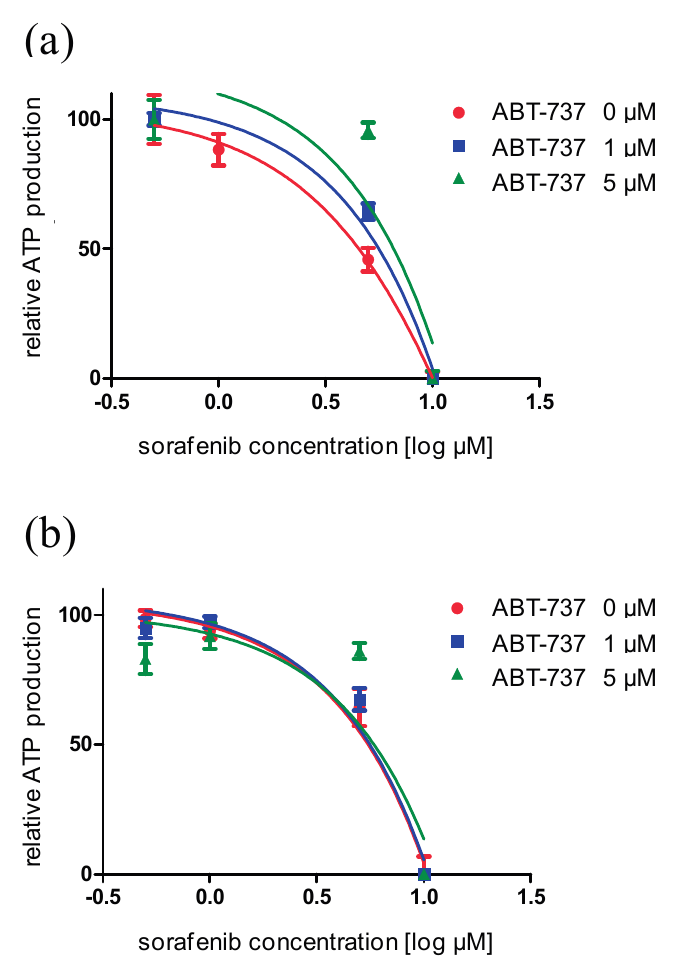
Figure 6. Dose-dependency of sorafenib effects on cell viability in combination with the Bcl-2 inhibitor ABT-737 as measured by total ATP levels, shown exemplarily in T24 cells. Cells were treated with both compounds over ( a ) 24 and ( b ) 72